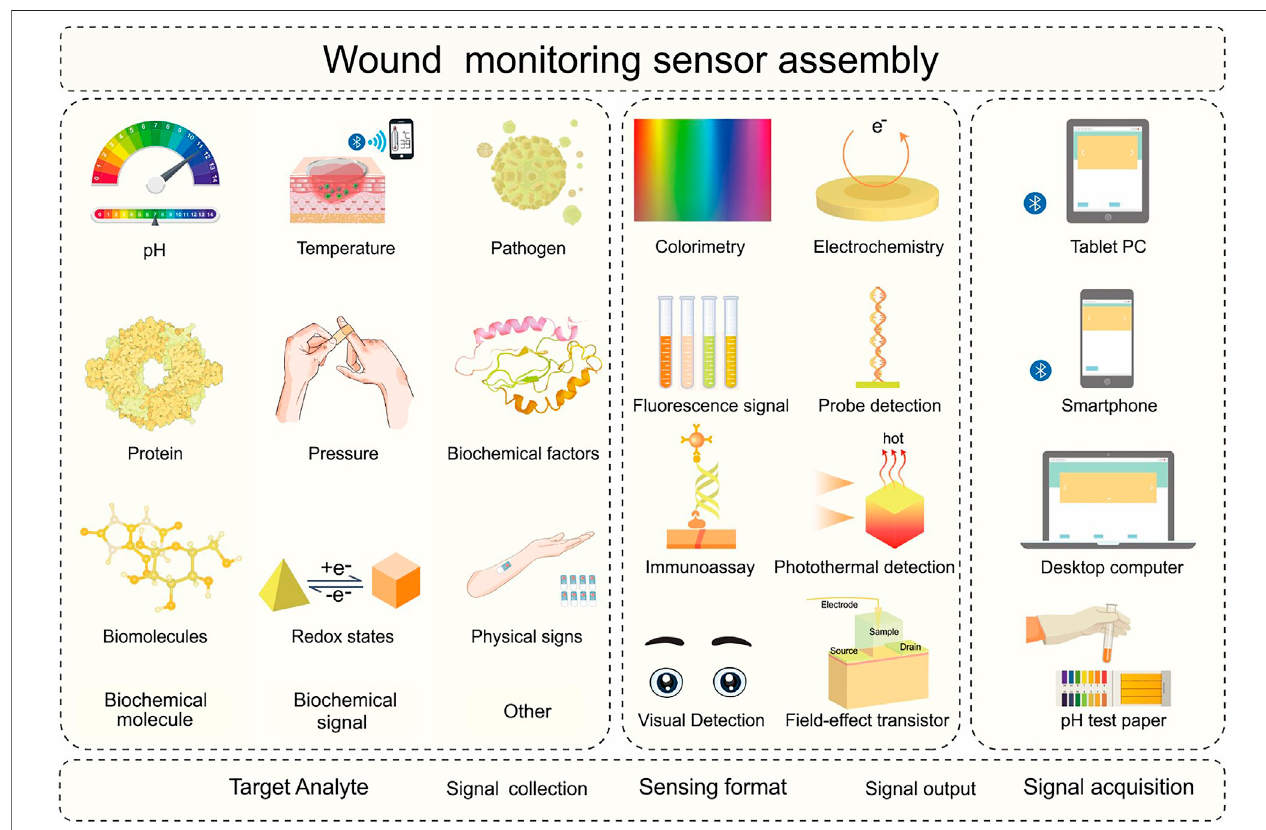
FIGURE 3 | Schematic diagram of the sensing process and integration of the wound monitoring sensor. The target analyte identi fi cation element in the wound monitoring sensor can selectively collect various target analytes in different bio fl uids. The signal processing elements can collect signals using various biochemical sensing formats. The signal acquisition element can process and output analytical results intelligently. The target analytes may include biochemical molecules (potential hydrogen, protein, biomolecules), biochemical signals (temperature, pressure, redox status), and other parameters (pathogens, biochemical factors, physical signs). Sensing formats include colorimetry, fl uorescence signal, immunoassay, visual detection, electrochemistry, probe detection, photothermal detection, and Field- effect transistor. Signal acquisition components include pH test strips, computers, tablets, and mobile